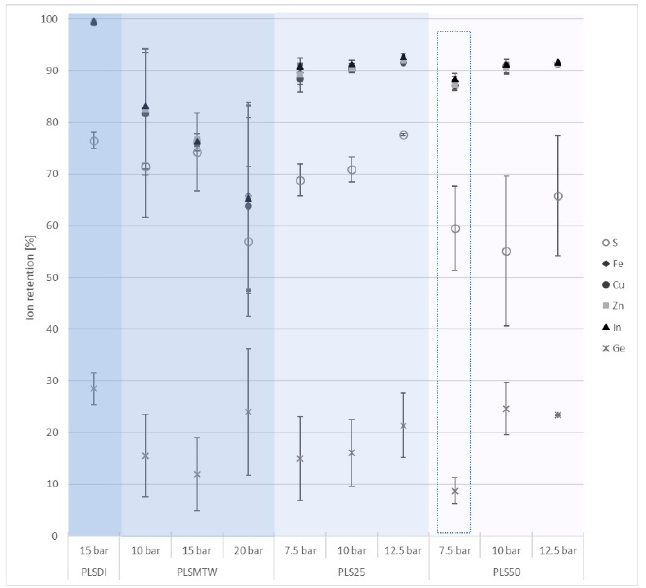
Figure 9. Pressure dependent ion retention for PLS DI , PLS MTW , PLS25, and PLS50 depending on pressure at 1.1 m s − 1 overflow velocity.